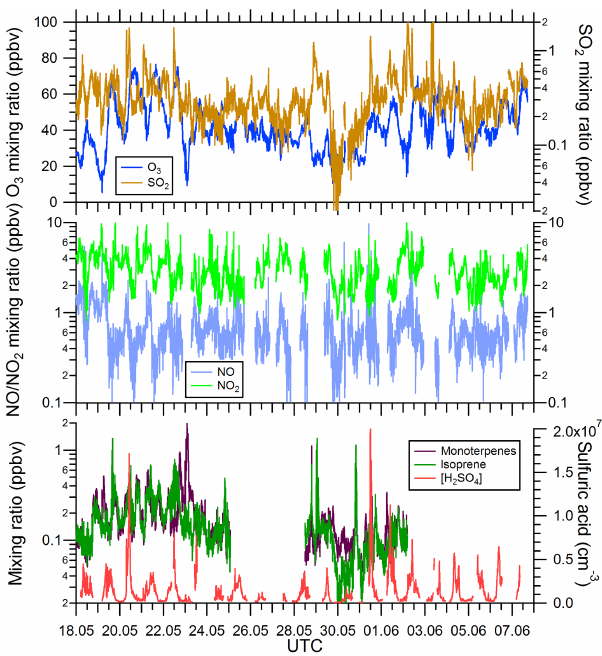
Figure 2. Overview of the trace gas measurements between 18 May and 8 June 2014. The SO 2 and O 3 mixing ratios are shown in the upper panel, the NO and NO 2 mixing ratios are shown in the center panel, and the bottom panel shows the sulfuric acid monomer con- centration ([H 2 SO 4 ]) together with the isoprene and monoterpene mixing